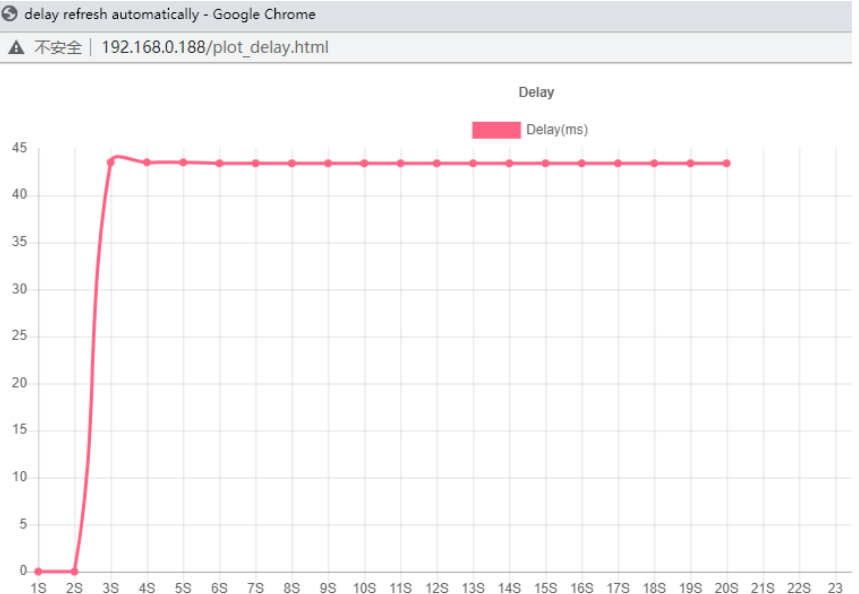
Figure 11. The delay results of method 3 in the form of web pages. The Chinese words in the picture are “unsafe”. Table 2. Pro and cons of 3 proposed Table 1. Latency results in the First 10 s of video transmission.